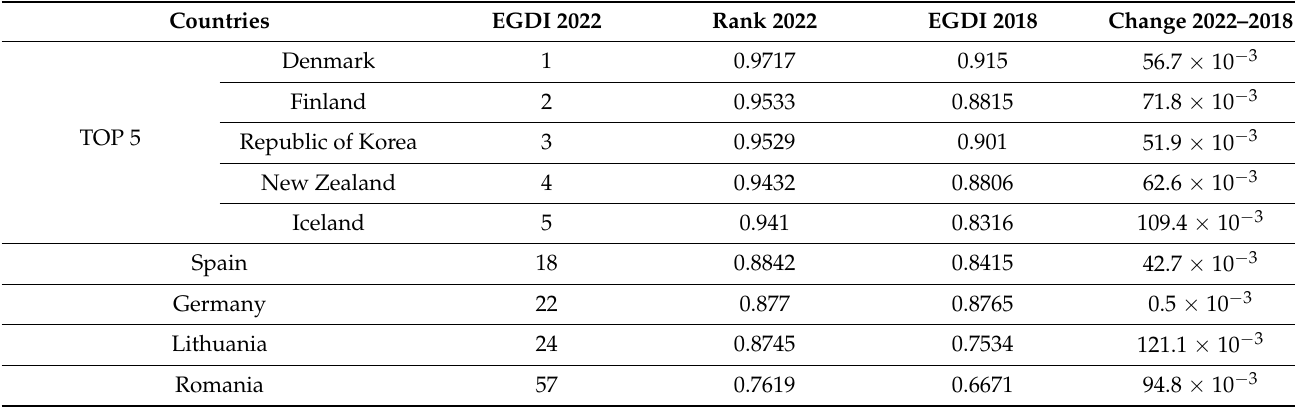
Table 4. EGDI levels in selected countries and the five best